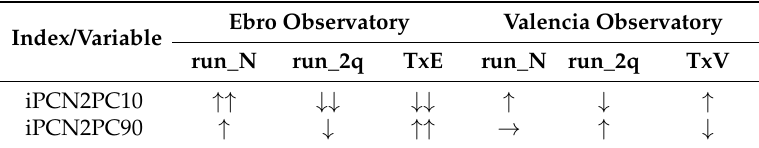
Table 3. Relation between iPCN2 and wind and